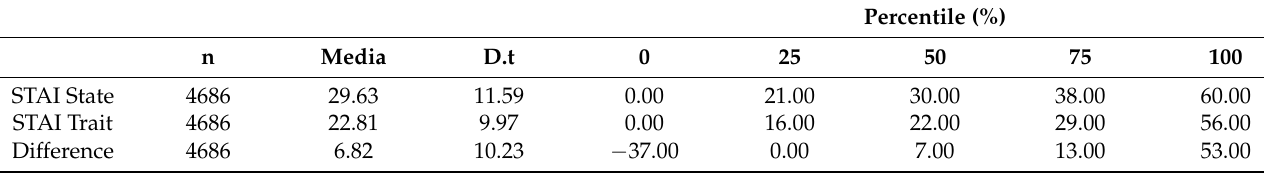
Table 8. Difference between STAI trait and STAI state.